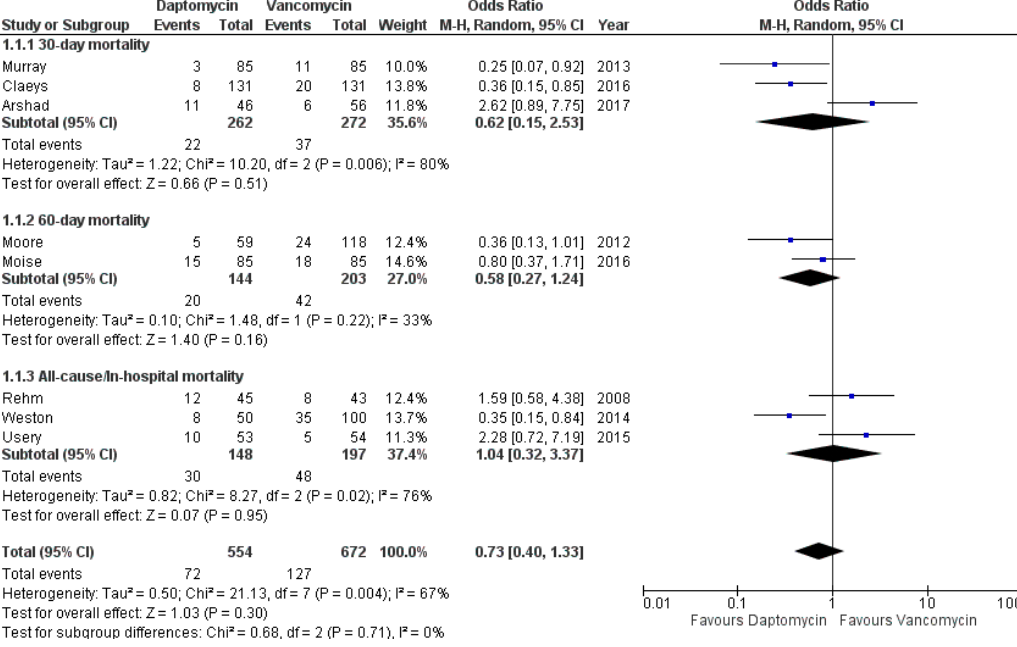
Figure 2. Forest plot depicting the odds ratios of mortality of patients receiving daptomycin vs. vancomycin.